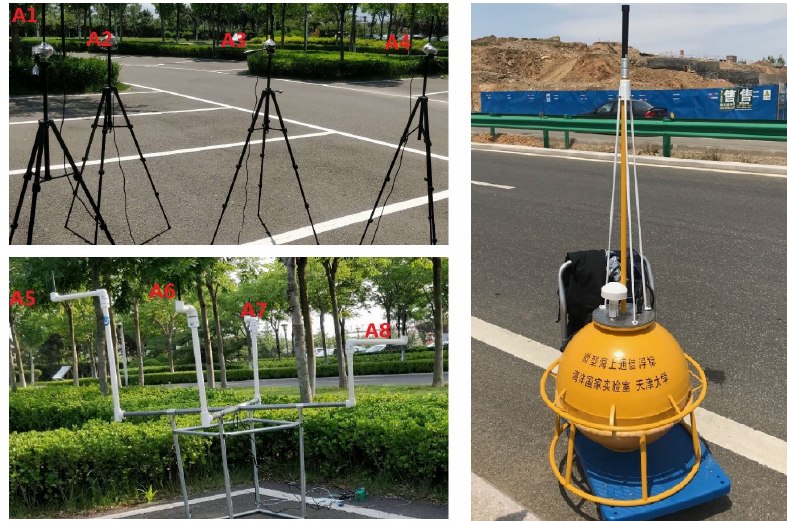
Figure 8. The sink node and the sensor node in the park